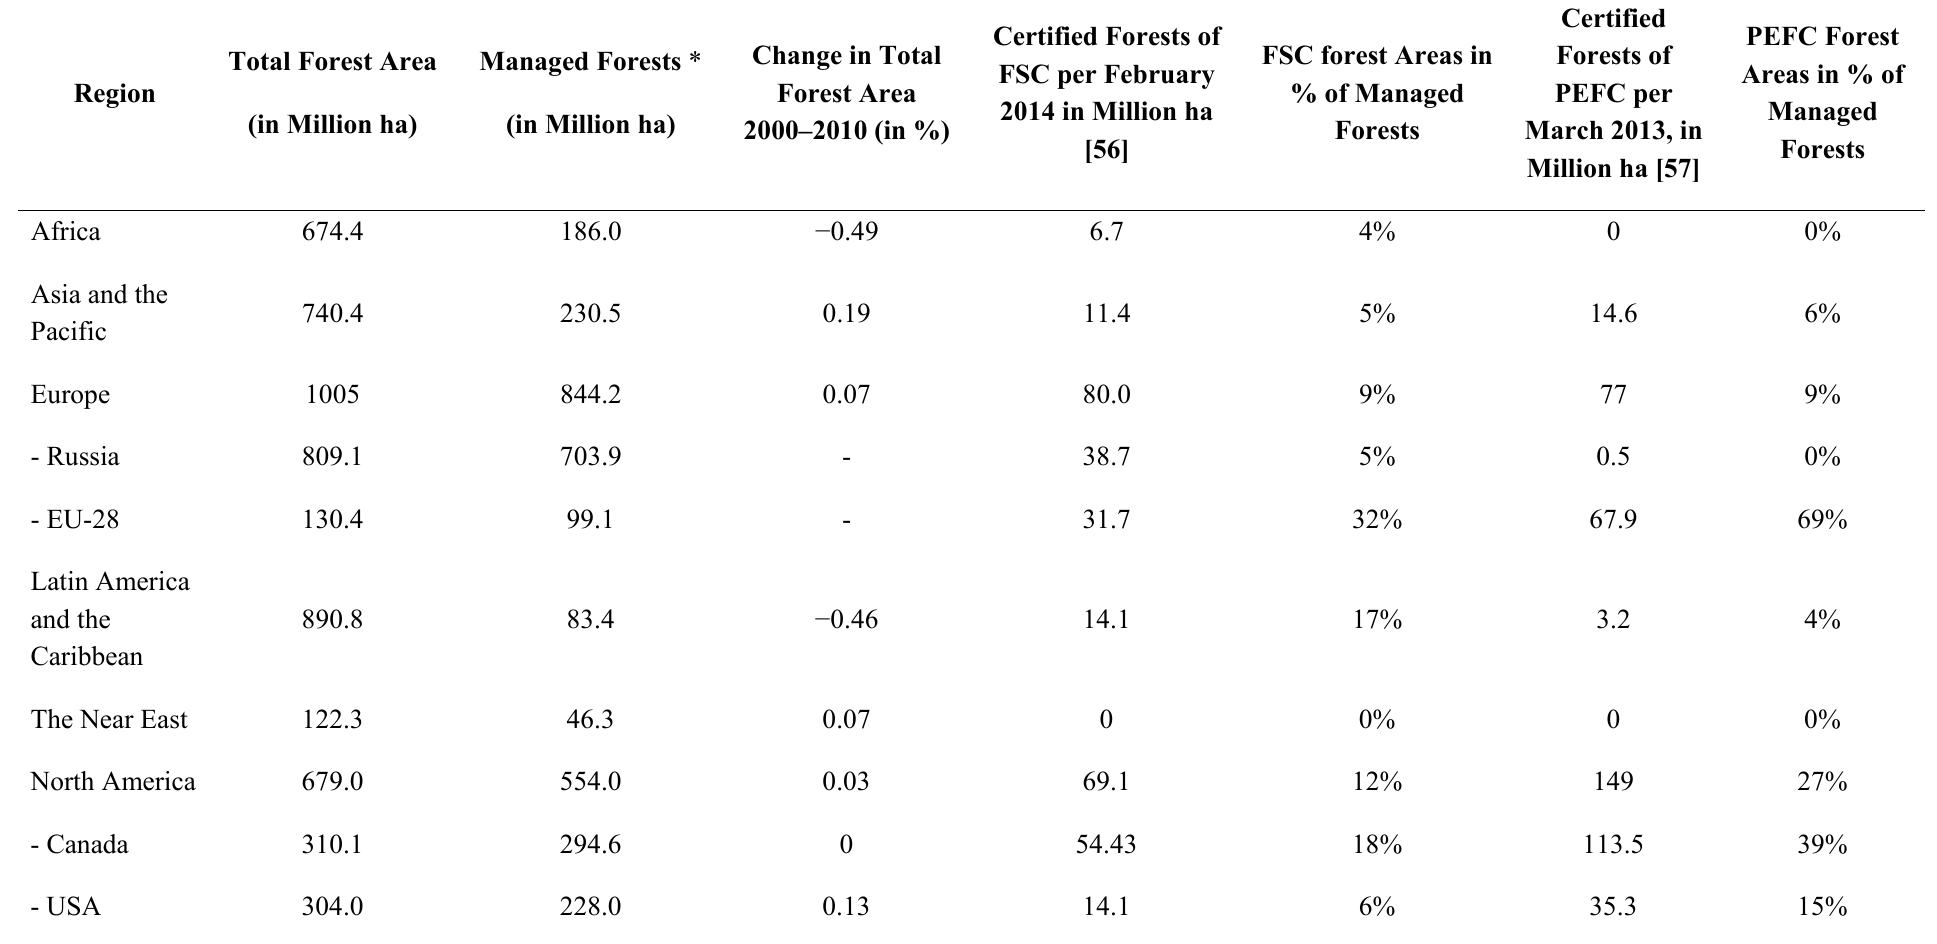
Table 2. Forest areas worldwide [54,55] and updated forest certification